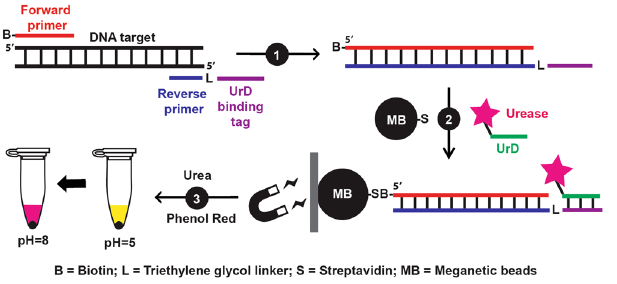
Figure 1. Assay principle. (1) PCR reaction. (2) Immobilization of PCR product and urease labeled DNA onto magnetic beads. (3) Litmus